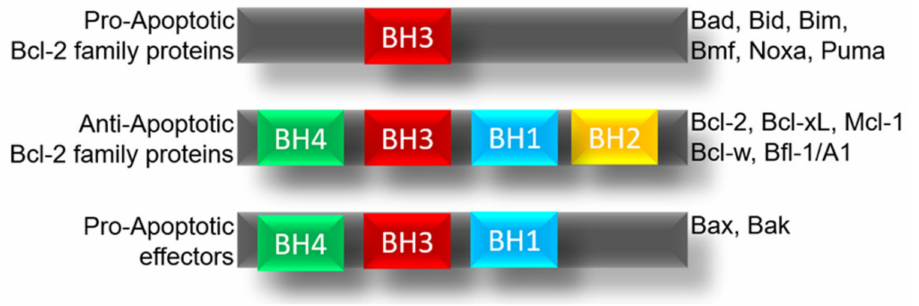
Figure 1. Members of the BCL-2 family and their role. Schematic representation of the members of BCL-2 family and his subunits.